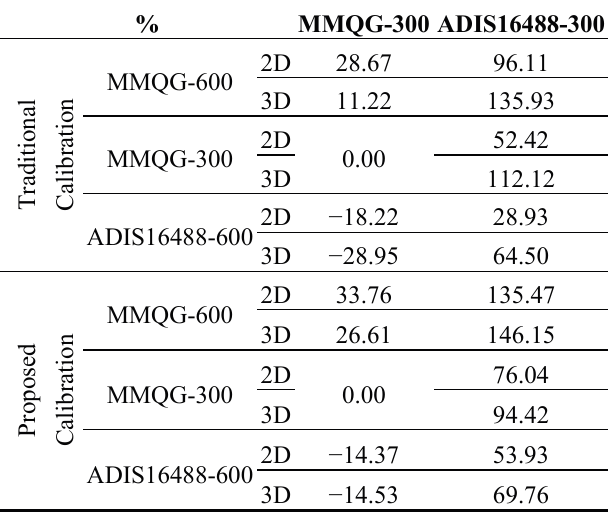
Table 4. The improvement rate of DG accuracy based on different flight and DG